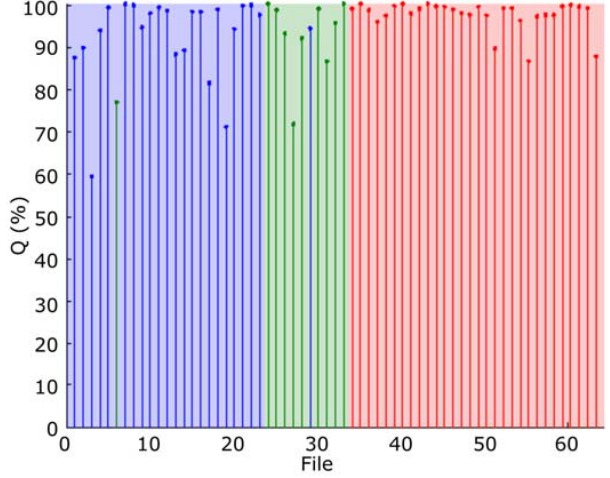
Figure 16. Classification result of all the samples of the audio collection.